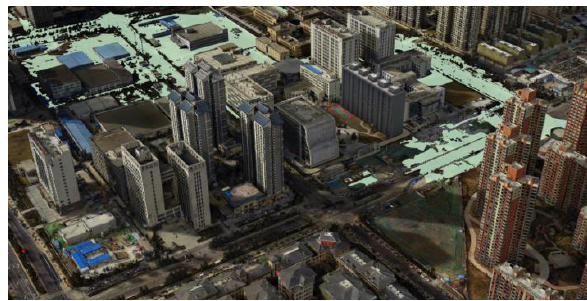
Figure 9.Flood inundation scenario (flood simulation scenario, the blue part is the flooded area)